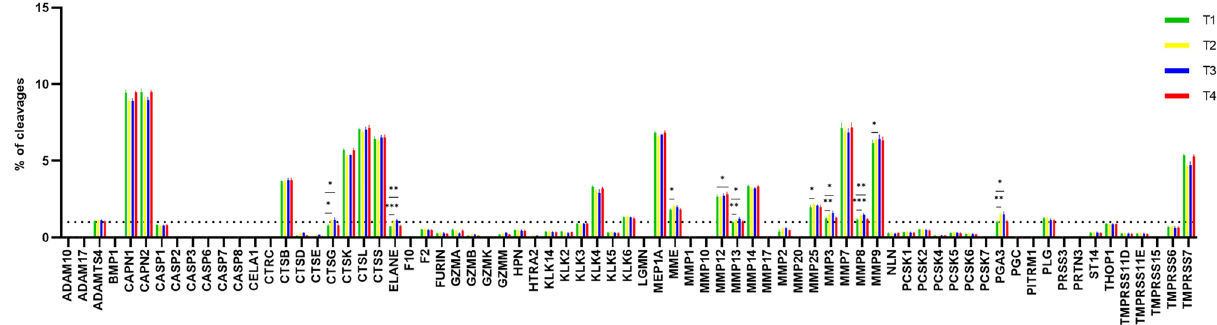
Figure 2. Graph showing the profile of all proteases as predicted by Proteasix. The bars represent the percentage of cleavages for each predicted protease at four time-points. T1 baseline (before placement of orthodontic appliance), T2 1 h after placement of orthodontic appliance, T3 1 week after placement of orthodontic appliance, T4 end of the alignment. The interrupted line represents a percentage threshold (1%) to consider the activity of the proteases. Data are shown as mean ± SD. Data were analysed by repeated measures ANOVA; *p < 0.05; **p < 0.01; ***p <